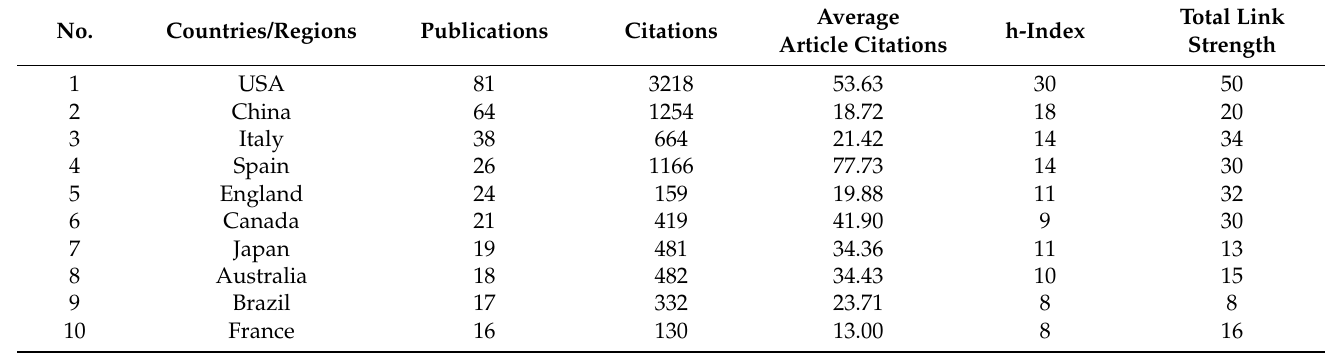
Table 1. Top ten countries/regions with the most publications.